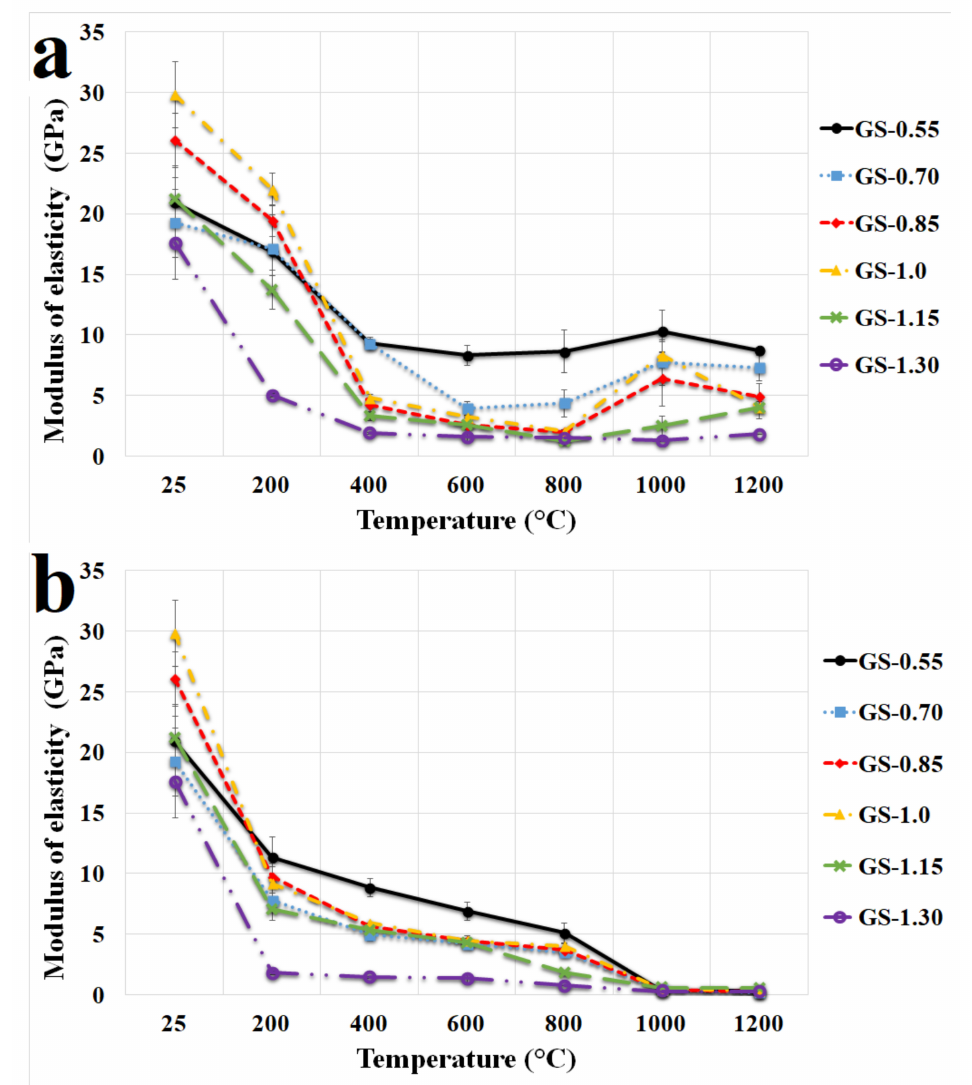
Figure 8. Modulus of elasticity of the geopolymer composites with various molar ratios of K/Al at laboratory temperature and after exposure up to 1200 ◦ C ( a ) and in situ temperature from 25 ◦ C to 1200 ◦ C ( b